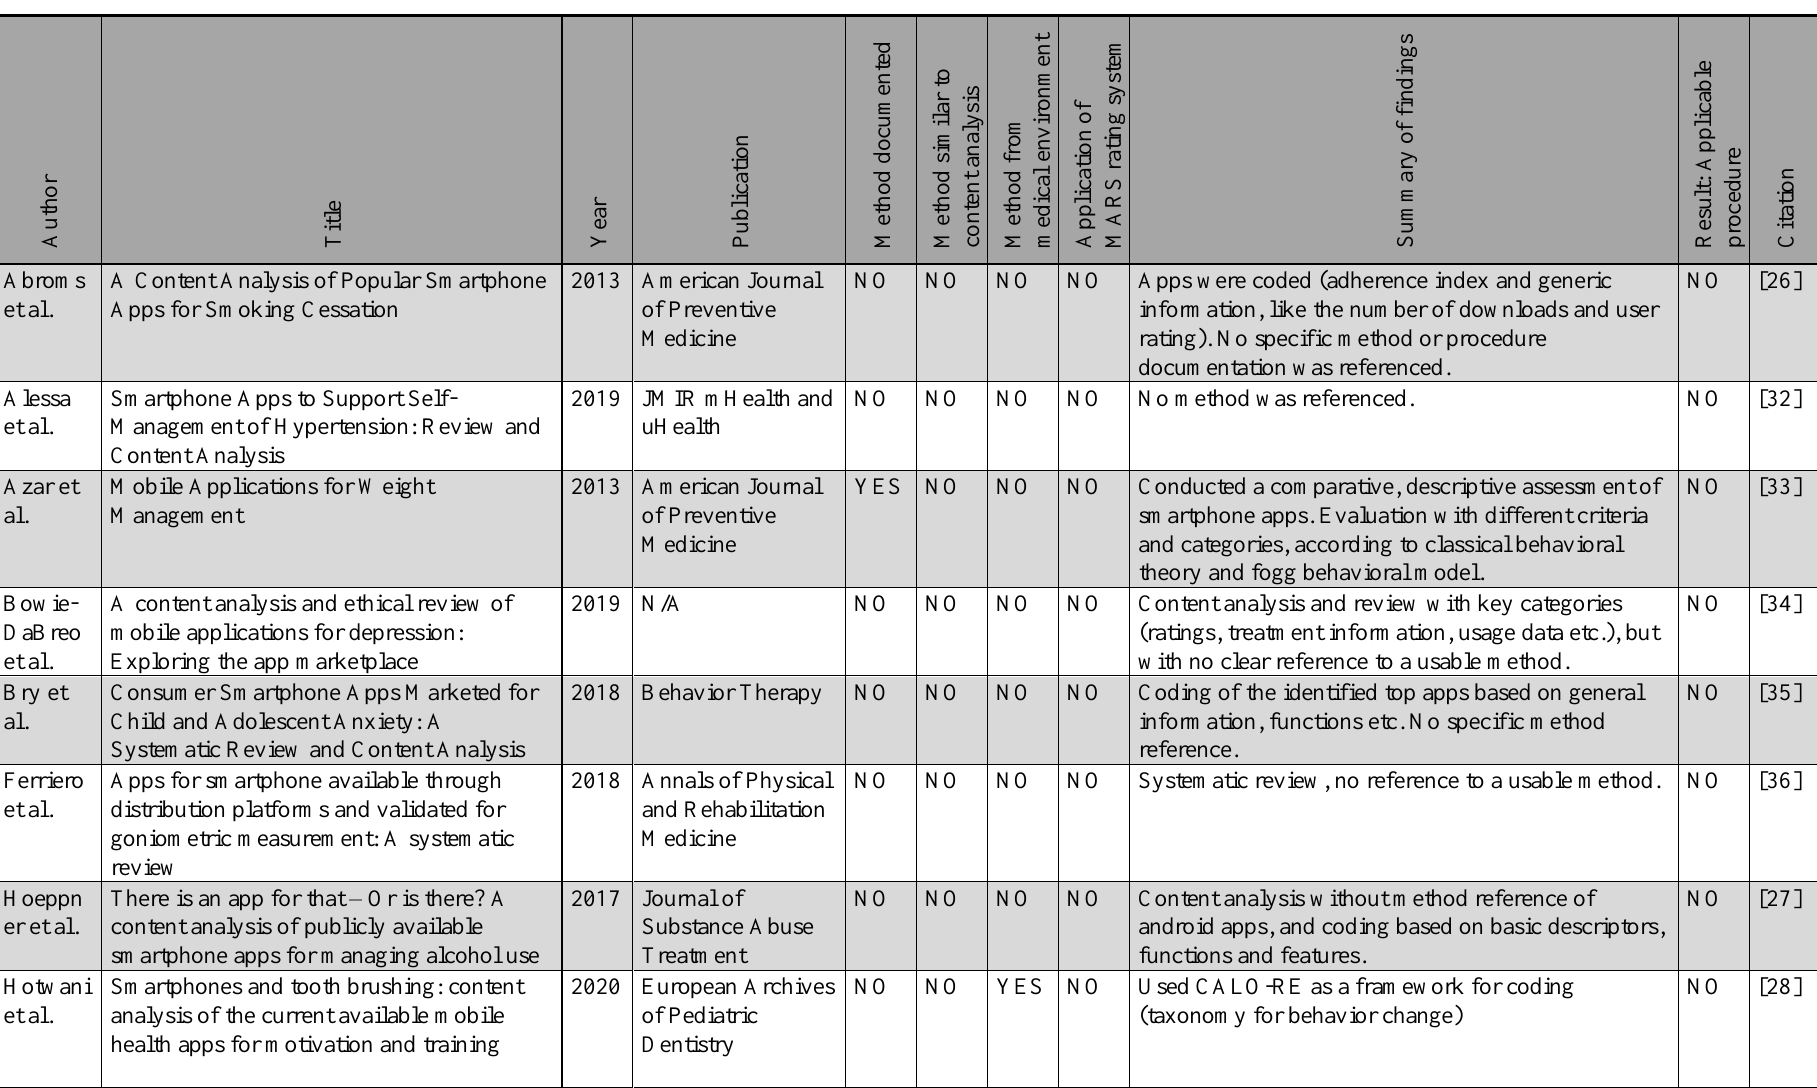
Table 1. Results of the literature